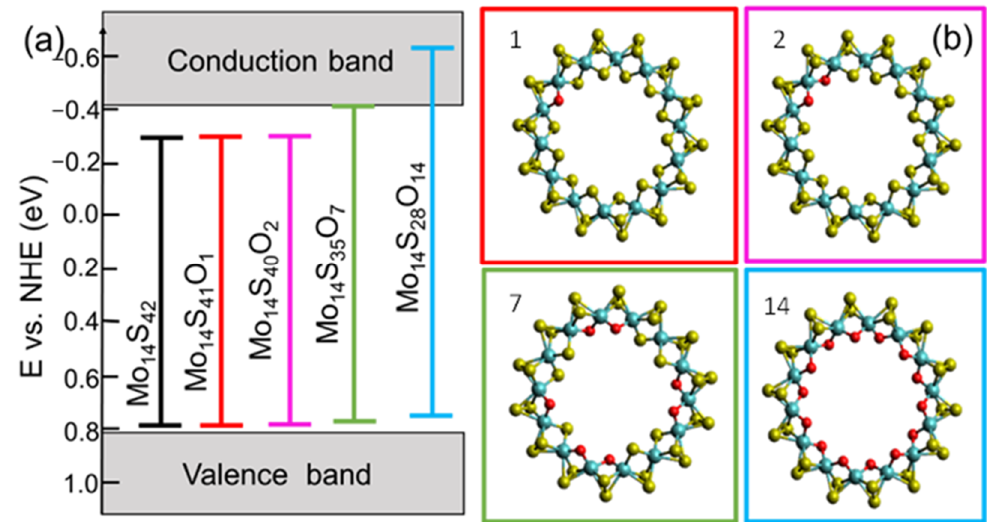
Figure 7. Energy diagram of the valence and conduction bands of Mo 14 S 42 − X O X cluster at x = 0, 1, 2, 7, 14, in comparison with a normal hydrogen electrode ( a ) and changes in the amorphous structure of Mo 14 S 42 − X O X upon oxygen substitution for sulfur ( b ). (1) x = 1, (2) x = 2, (7) x = 7, (14) x =14.